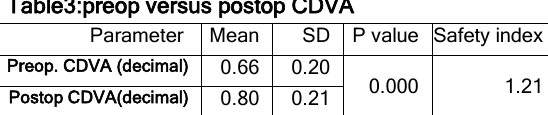
Table3:preop versus postop